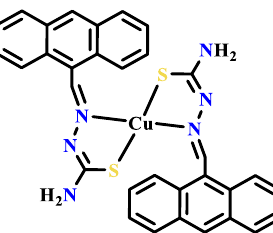
Figure 38. A copper(II) complex of 9-anthrachydrazone with thiourea as a side chain.